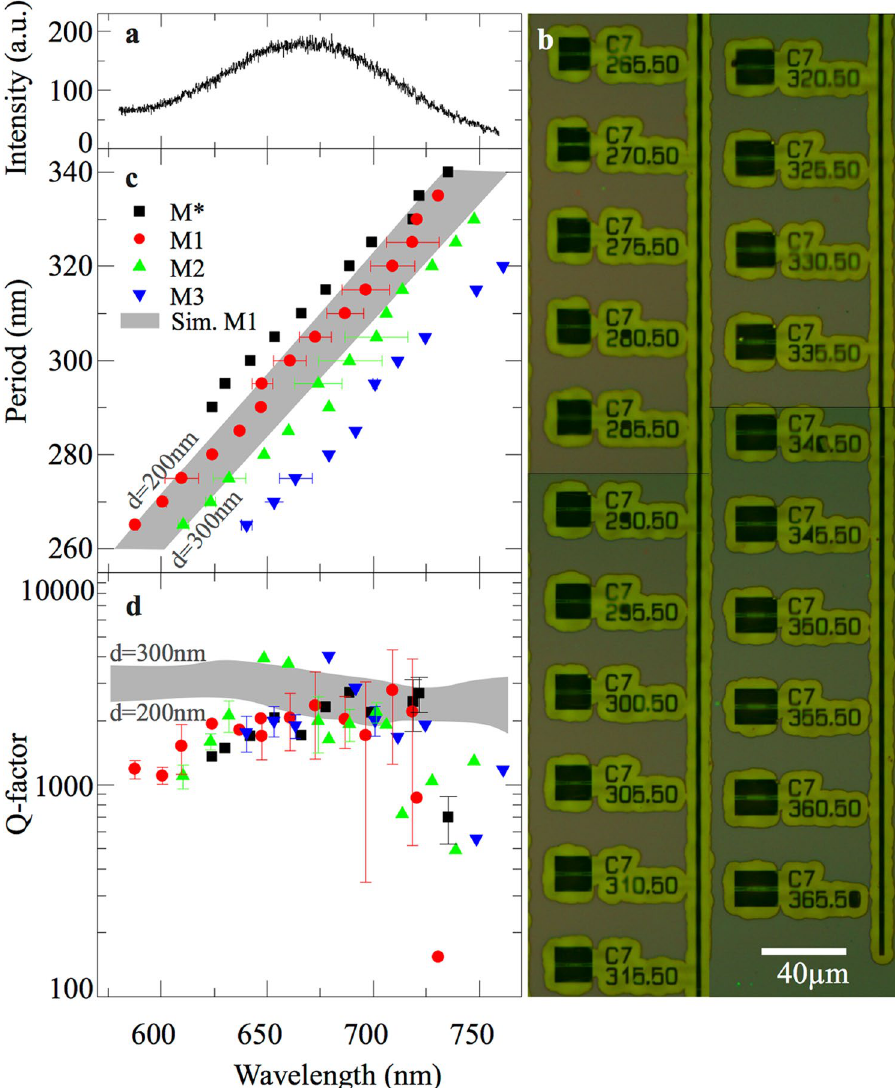
Figure 4. Tuning analysis and comparison to FDTD simulations. ( a ) A typical MoS 2 PL spectrum. ( b ) Optical microscope image of an array of 21 PCC devices fabricated on a continuous MoS 2 film. ( c ) Geometric tuning analysis – The PCC periods within the set of cavities of Fig. 3 are plotted as a function of the mode wavelength they support. M1, M2, M3 show excellent agreement with the linear tuning predicted by FDTD simulations for a SiO 2 thickness between d = 200 nm and 300 nm (grey shaded area). ( d ) Experimentally observed Q-factor of the three dominant modes as a function of the wavelength the PCC supported. These values agree nicely with FDTD simulation results for M1 (grey shaded